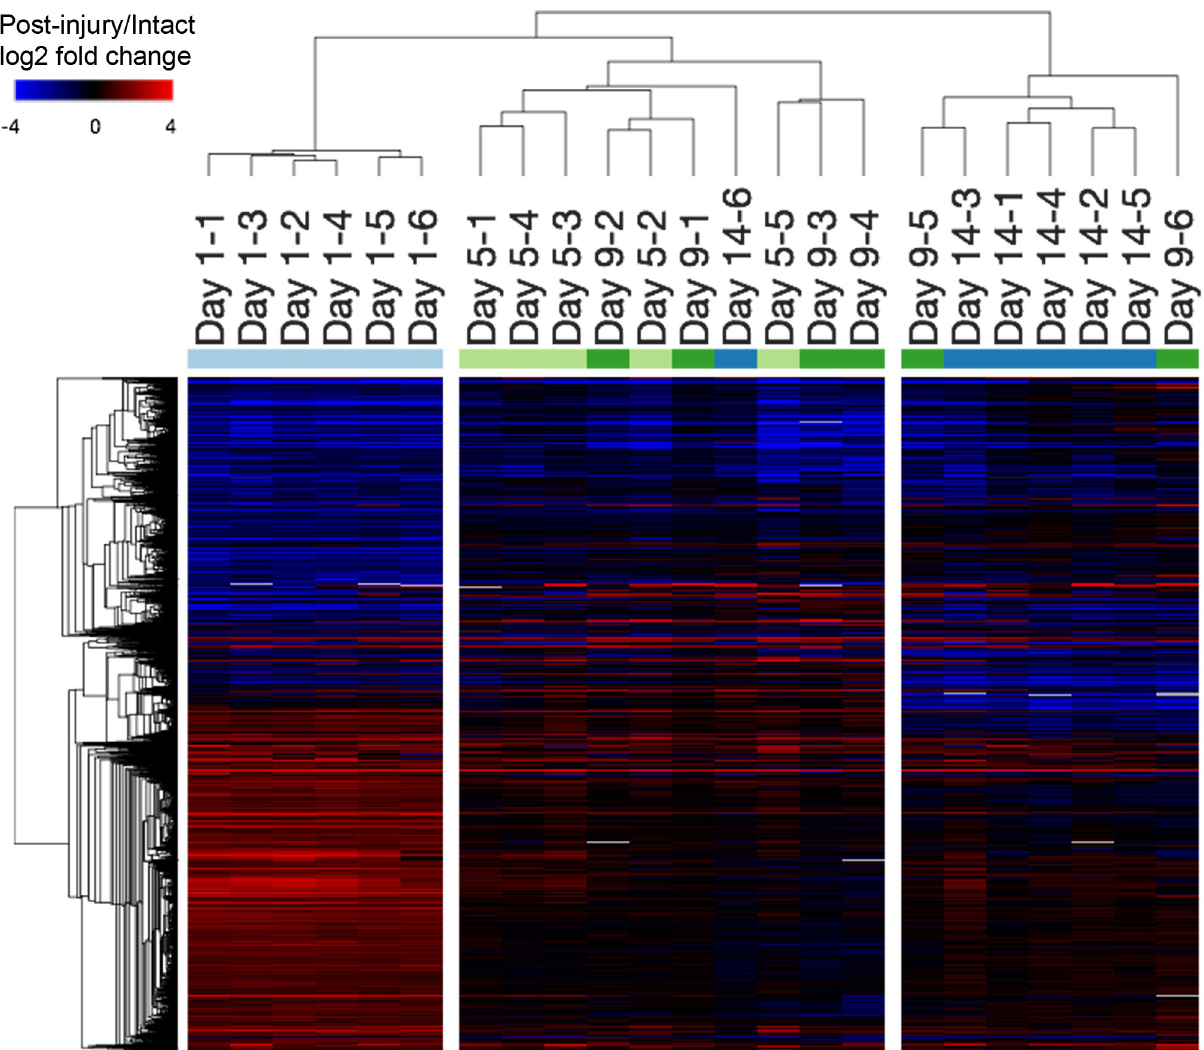
Fig 1. Transcriptional response of synovium to joint injury. Heatmap depicting the relative transcript abundance levels compared to intact controls (log-2 fold change of the individual post-injury specimens over the mean of the intact controls; red indicates higher expression following surgery, blue indicates lower expression). All 4109 transcripts (rows) differentially expressed in at least one of the assessed post-surgery time-points were included. Hierarchical clustering of post-surgery samples revealed 3 clusters: One distinct cluster containing all 1 day post-surgery samples, one cluster containing mostly 5 and 9 day post-surgery samples, and another containing mostly 14 day post-surgery samples, suggesting that the early transcriptional response at 1 day post-surgery is extensive and somewhat distinct from the later post-surgery time-points.